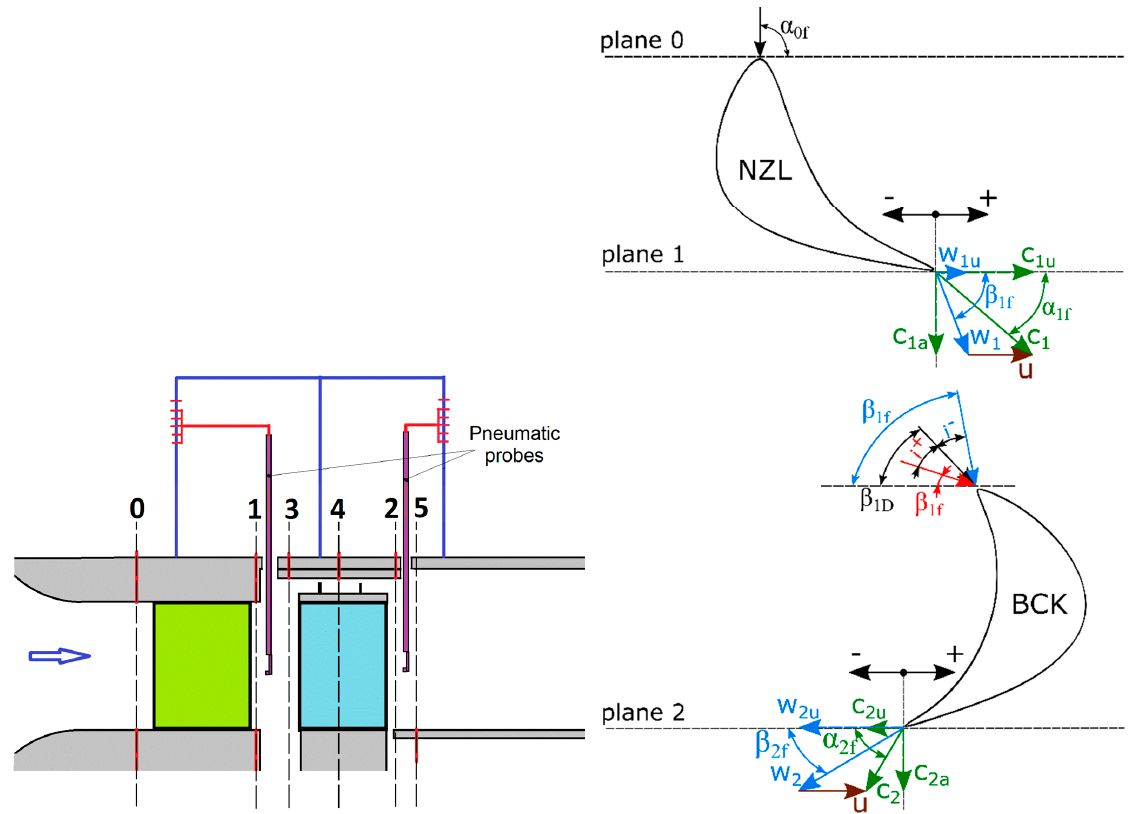
Figure 2. Turbine stage measured planes ( left ) and velocity/angle orientation ( right ) [1].